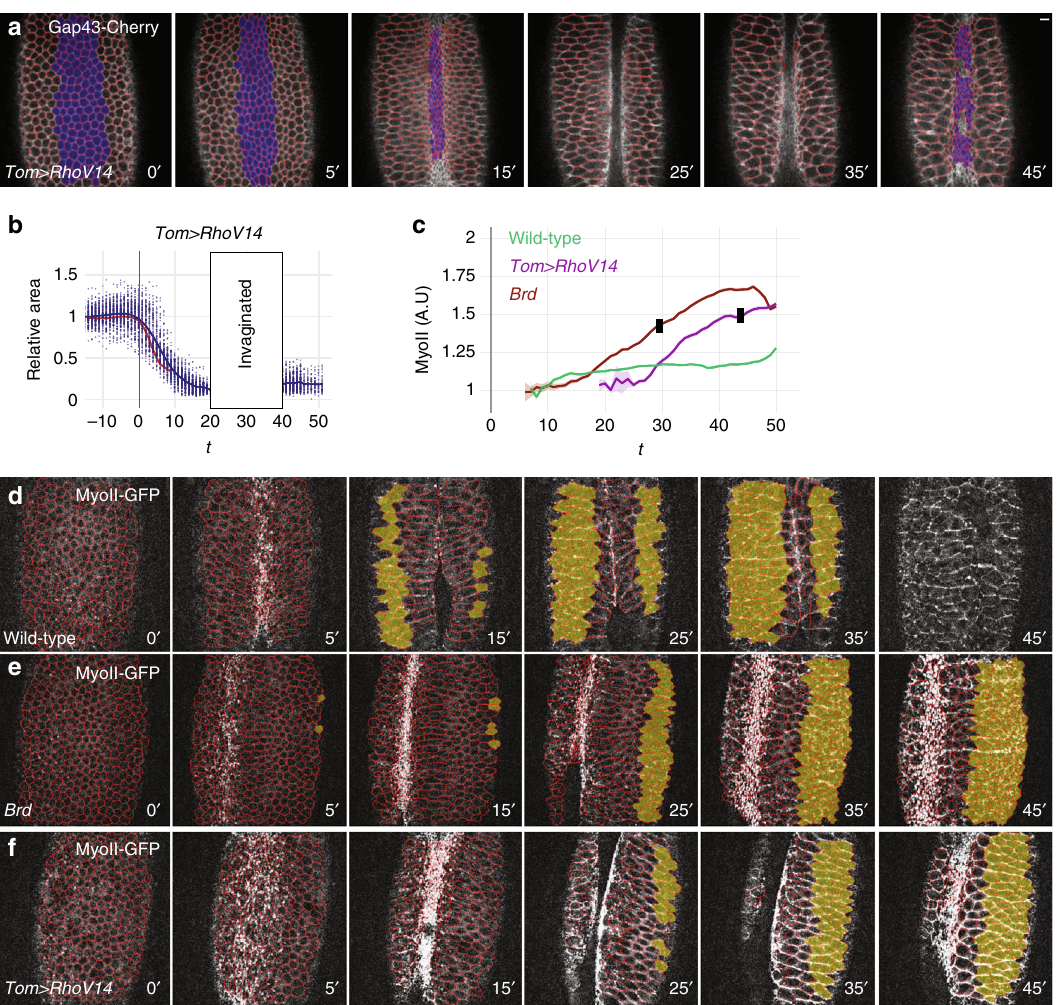
Fig. 6 Increased contractility in the ectoderm is suf fi cient for furrow unfolding. a , b Snapshots from a Tom > RhoV14 embryo movie (ventral view; Gap43- Cherry, white, and tracking, red). This embryo also expressed MyoII-GFP. While ventral furrow formation ( a ) and collective apical constriction ( b ; wild-type control, red) occurred normally, furrow unfolding was observed soon afterwards. c Mean MyoII intensity values measured in tracked ventral cells of wild- type (green), Brd (brown), and Tom > RhoV14 (purple) embryos were plotted over time. Black stamps indicate the onset of furrow unfolding (mean values; see Supplementary Fig. 9e for the complete data set). d – f Snapshots from movies wild-type ( d ), Brd mutant ( e ), and Tom > RhoV14 ( f ) embryos expressing MyoII-GFP (white) and Gap43-Cherry (tracking, red). Ventral – lateral views are shown. MyoII-GFP intensity was measured in ventral ectodermal cells (yellow-shaded in d – f ) of wild-type ( n = 3), Brd mutant ( n = 3), and Tom > RhoV14 ( n = 3)